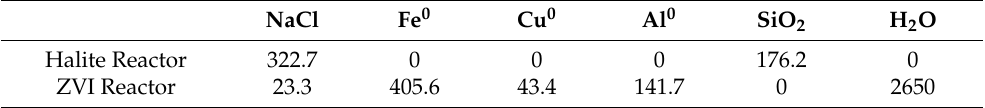
Table 1. Halite and ZVI composition used. All amounts are in grams. Halite Reactor column length = 6 m, 15 mm O.D. ZVI Reactor water column length above the gas distributer = 8.3 m, 22 mm